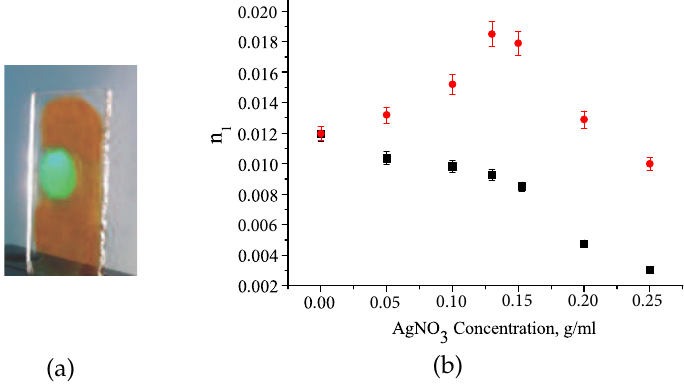
Figure 8. Photo of the grating polymer–Ag NPs ( a ). The dependence of n 1 of the grating before (black squares) and after (red circles) the treatment on the AgNO 3 concentration in a precursor solution ( b